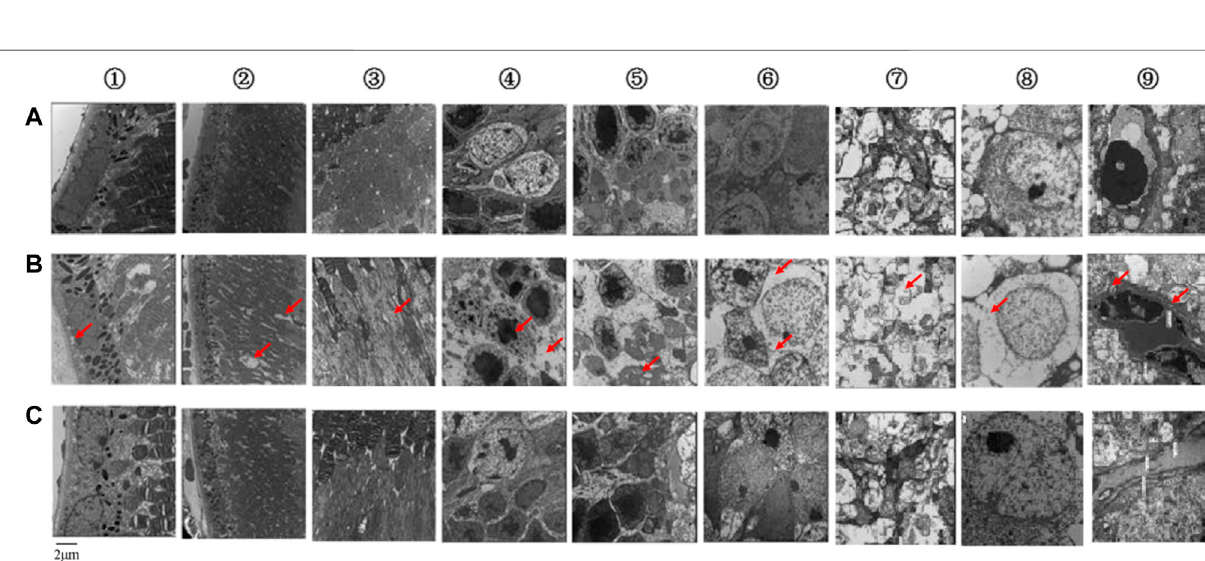
the control group from 8 weeks of age, at > 11.1 mmol/L ( Figure 1B ). Urine glucose was negative in the control group but positive in the model group ( Figure 1C ). Based on BW, blood glucose, and urine glucose, we diagnosed these 8-week-old model mice with diabetes.